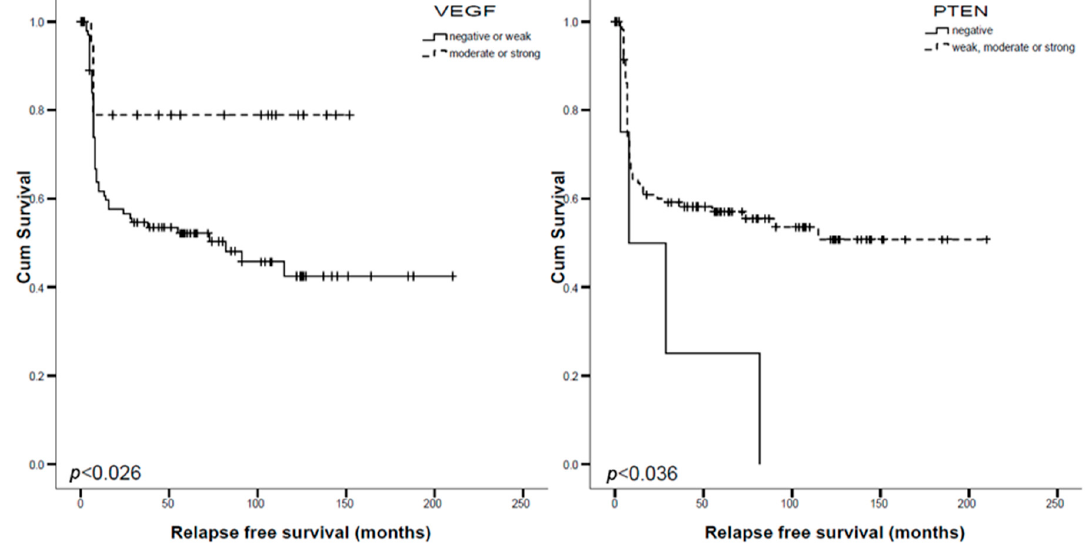
Figure 2. Kaplan–Meier Analysis for VEGF ( left ) and PTEN ( right ) and relapse free survival.